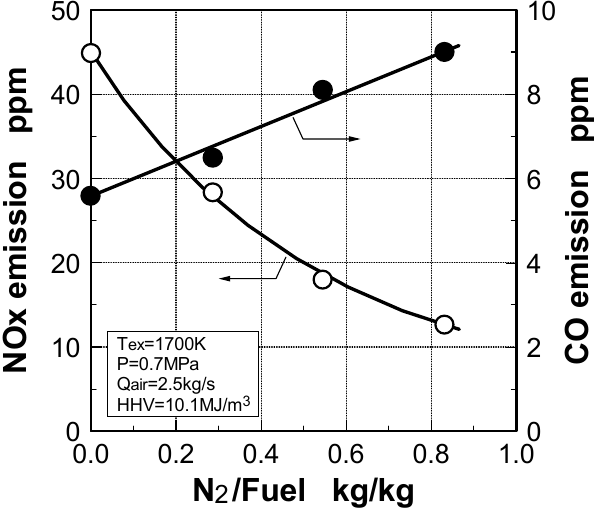
Figure 71. Effect of nitrogen injection flow rate from burner on combustion emission